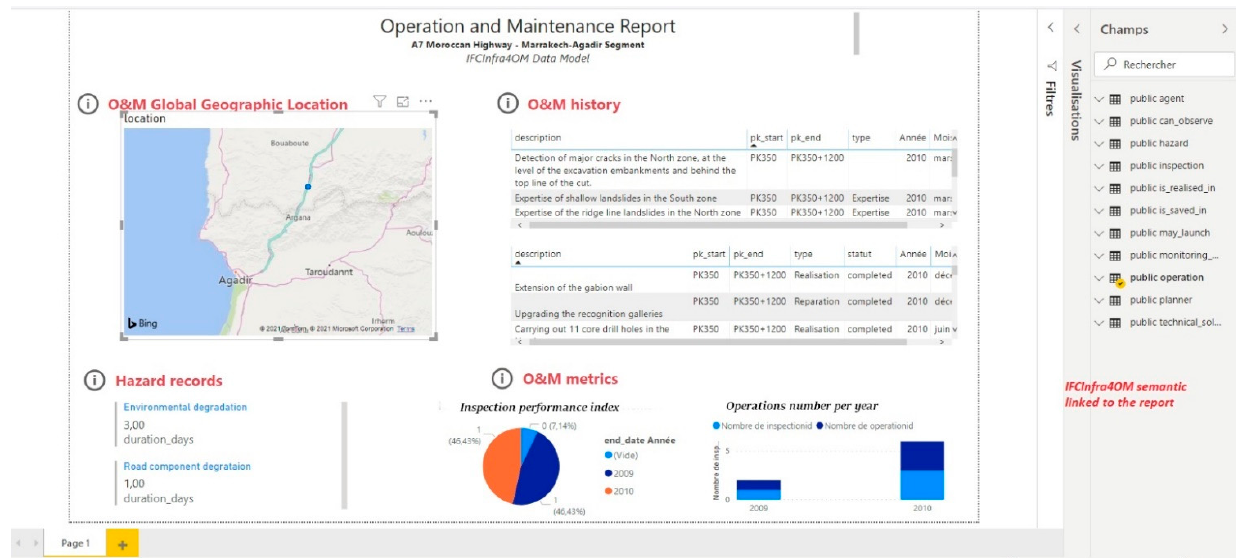
Figure 14. Use Case 2 : O&M Reporting Based on IFCInfra4OM Data Model (Power BI software).